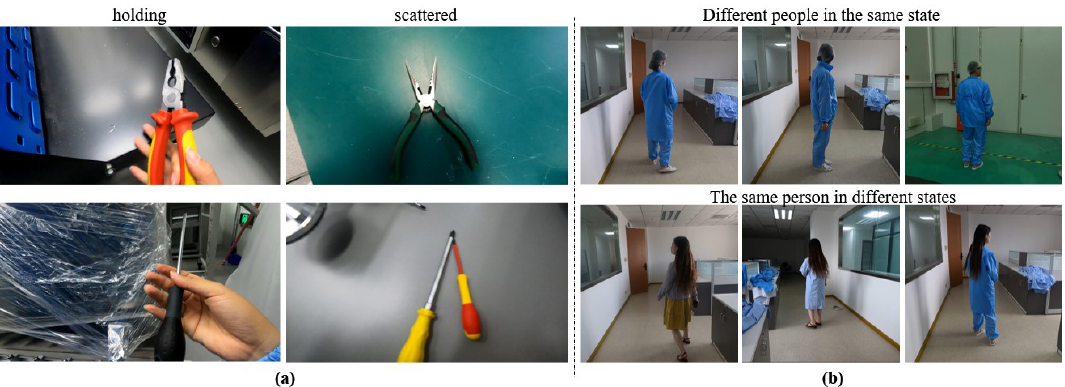
Figure 1. Examples of the two datasets. The left sub-graph ( a ) is from “object-state” showing different tools for the same state (column) and the same tool for different states (row). The right sub-graph ( b ) is samples of different people in the same state (1st row) and a person in different states ( 2nd row) from the